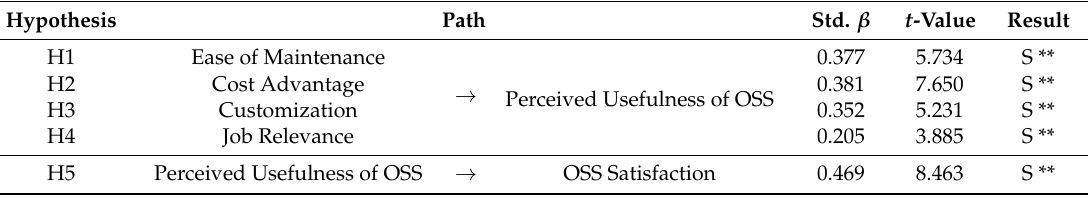
Table 7. Summary of hypothesis tests (Male group, n = 176).